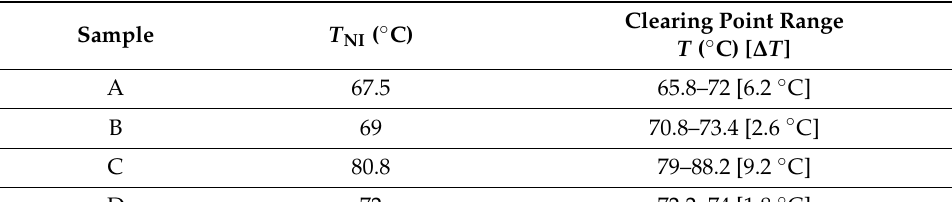
Table 4. Mesomorphic and thermal properties of LCs extracted from LC mixtures of EOL-LCDs A, B, C and D.